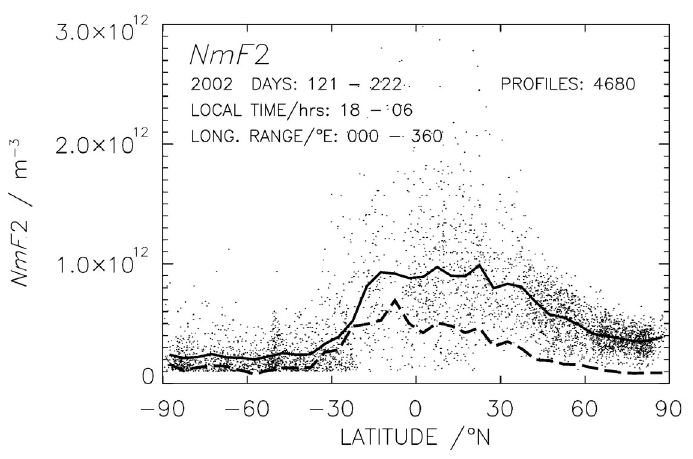
Fig. 7.9. Latitudinal distribution of NmF 2 for night-time hours (18-06 LT) during northern summer. The dashed curve represents the standard